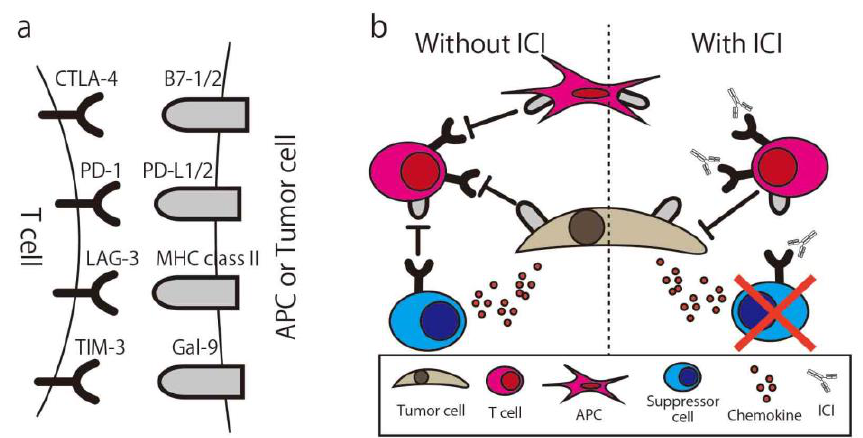
Figure 4. Immune Checkpoint Molecule and Immune Checkpoint Inhibitor. ( a ) The combination of common immune checkpoint molecules and their ligands. ( b ) Simplified illustration of the immune checkpoint inhibitor mechanism. CTLA-4, Cytotoxic T-Lymphocyte Associated Protein 4; PD-1, Programed cell death 1; LAG-3, Lymphocyte Activating 3; TIM-3, T-cell immunoglobulin mucin-3; Gal-9, galectin-9; ICI, Immune checkpoint inhibitor; APC, antigen-presenting cell.